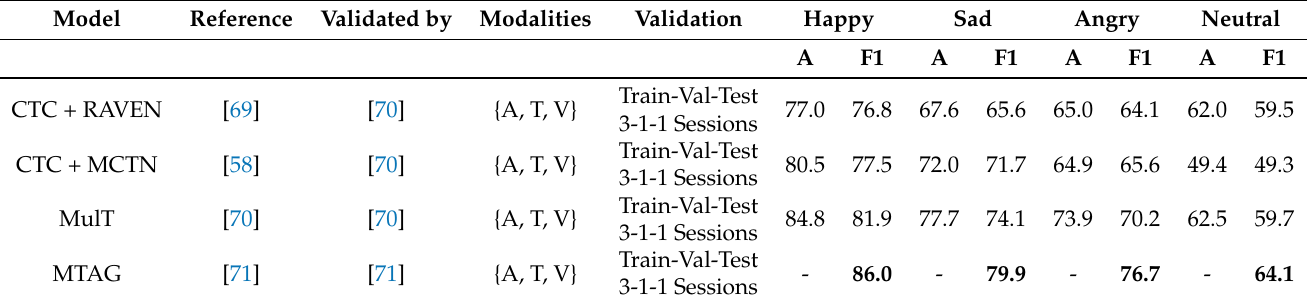
Table 3. Multimodal emotion recognition evaluation results for unaligned sequential input data. The works in which a specific multimodal architecture was validated are indicated under the “Validated by” column, while the type of validation is marked in the “Validation” column. For architectures that were not created to work in an unaligned manner, the CTC method was